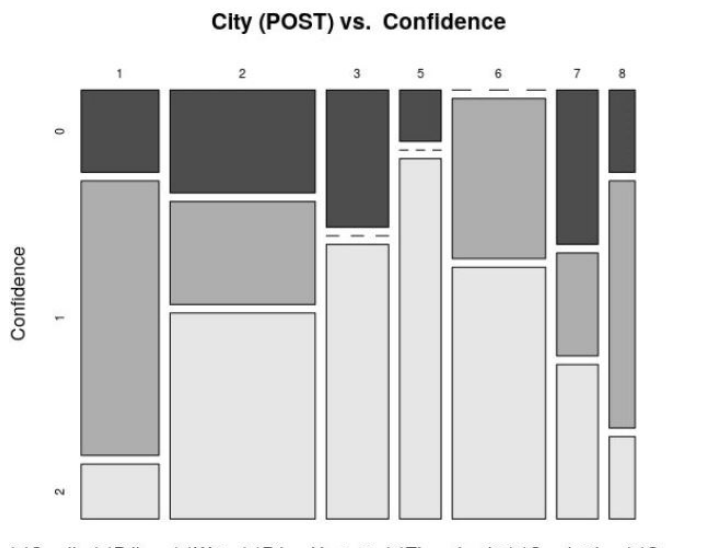
Figure 8. POST-pilot: Comparison of the distribution of confidence in technology among different pilots. Y axis: neutral (0), No Confidence (1) and Confidence (2).